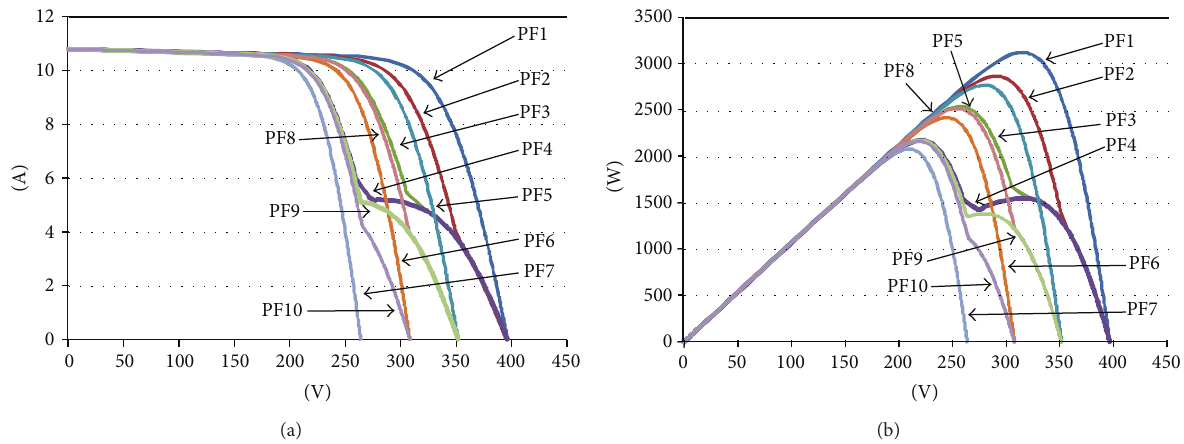
Figure10:Thesimulationcurvesofthenormaloperationsandvariousfaultsunderamoduletemperatureof31 ∘ Cand1,000W/m 2 irradiation: (a) I-V characteristic curve and (b) P-V characteristic curve.